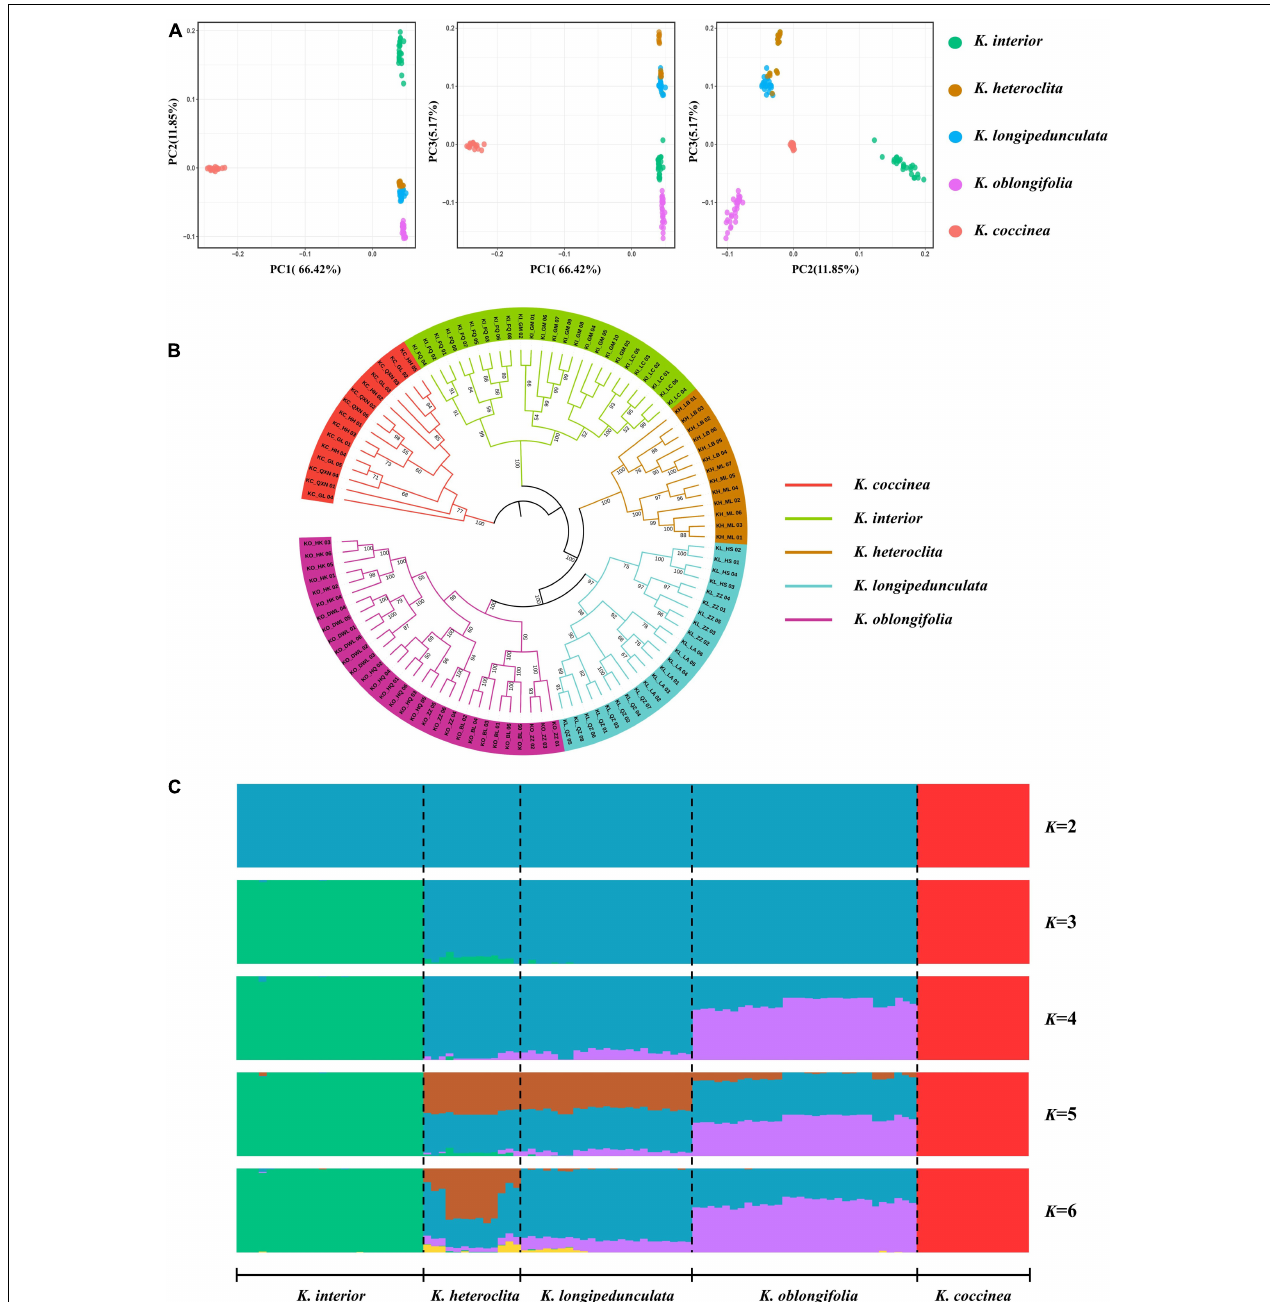
FIGURE 2 | (A) PCA plots of the first three components. PC1, PC2, and PC3 are abbreviations for the first three principles. Individuals of different species are represented in different colors. (B) The maximum-likelihood tree is based on SNPs. Individuals of different species are represented in different colors. The numbers on the branches are the related bootstrap supports. (C) STRUCTURE analyses for K = 2–6. Each color represents one genetic cluster. The five species are delimited by a dashed black